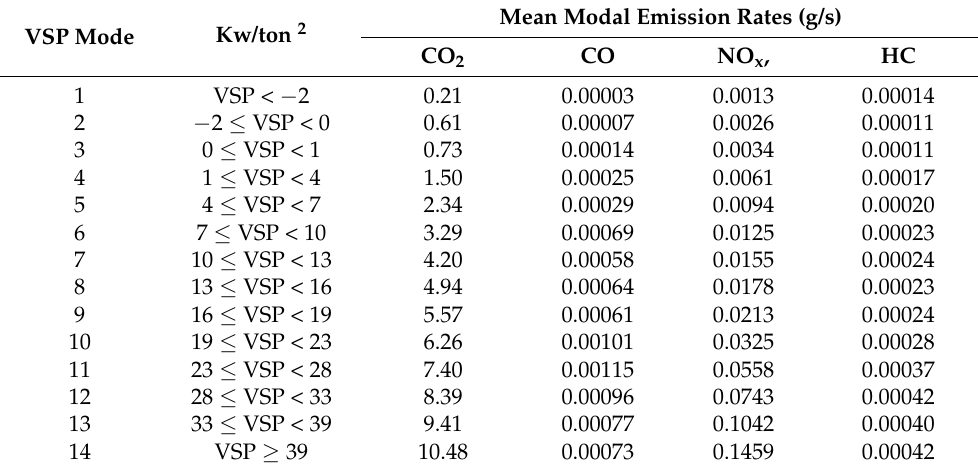
Table 4. The VSP modes, power requirements and mean emission rates by VSP mode for LPDV 1